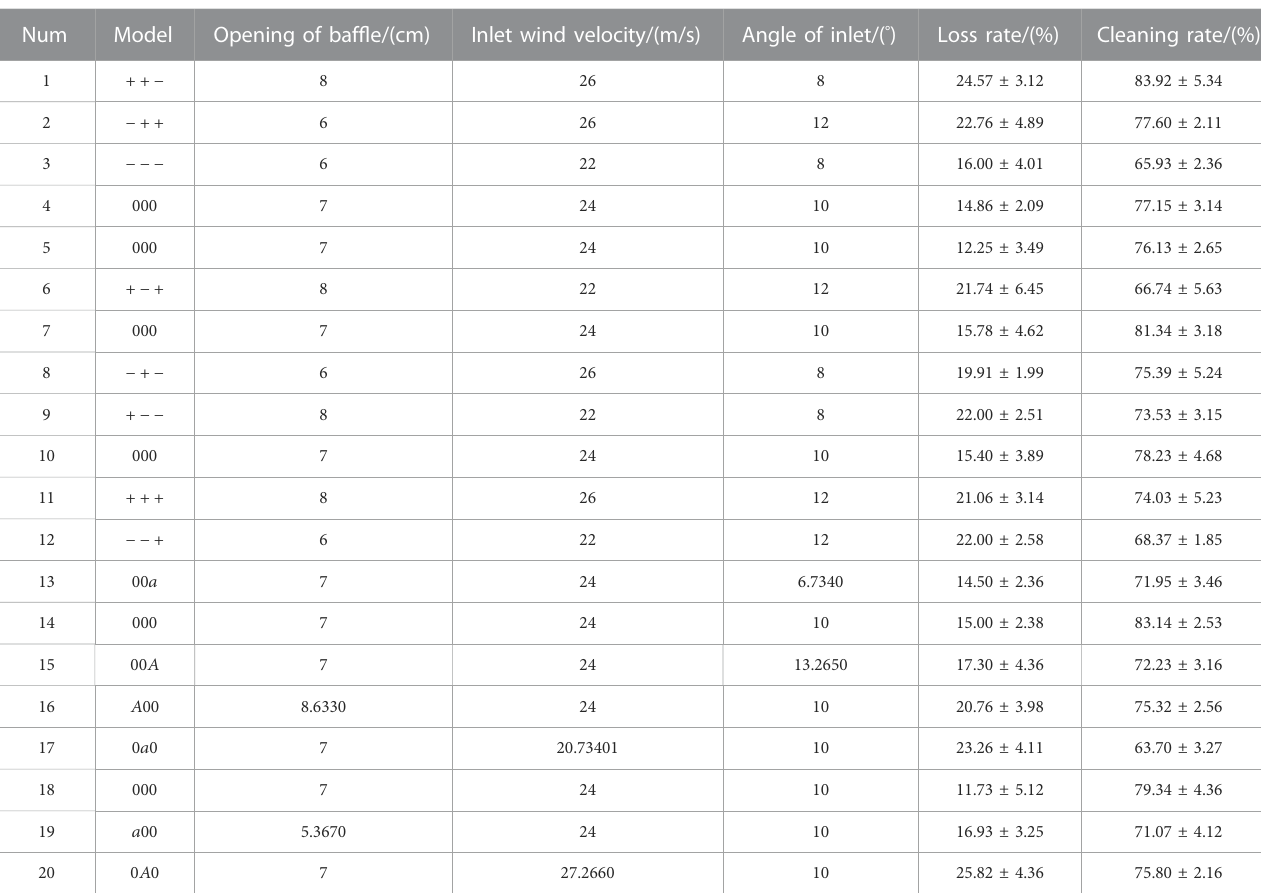
TABLE 3 Test design matrix and test results.